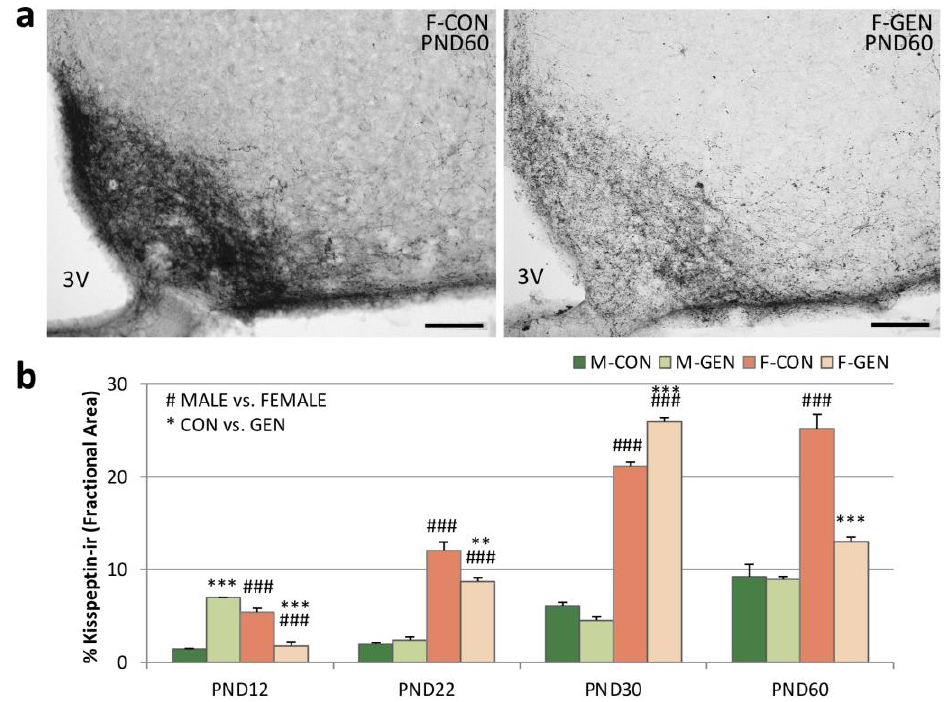
Figure 4. Kisspeptin immunohistochemistry. ( a ) Photomicrographs showing kisspeptin immunostaining in the ARC in adult (PND60) CD1 control (F-CON) and treated (F-GEN) female mice at PND60. 3V, third ventricle. Scale bar = 100 µm. ( b ) Histograms representing the variations of the percentage of area (FA; mean ± SEM) covered by kisspeptin immunopositive elements in the ARC of both sexes (M-CON, M-GEN, F-CON, and F-GEN) at different ages (PND2, PND22, PND30, and PND60). ** p ≤ 0.01; *** p ≤ 0.001; ## p ≤ 0.01; ### p ≤ 0.001 (Bonferroni test).